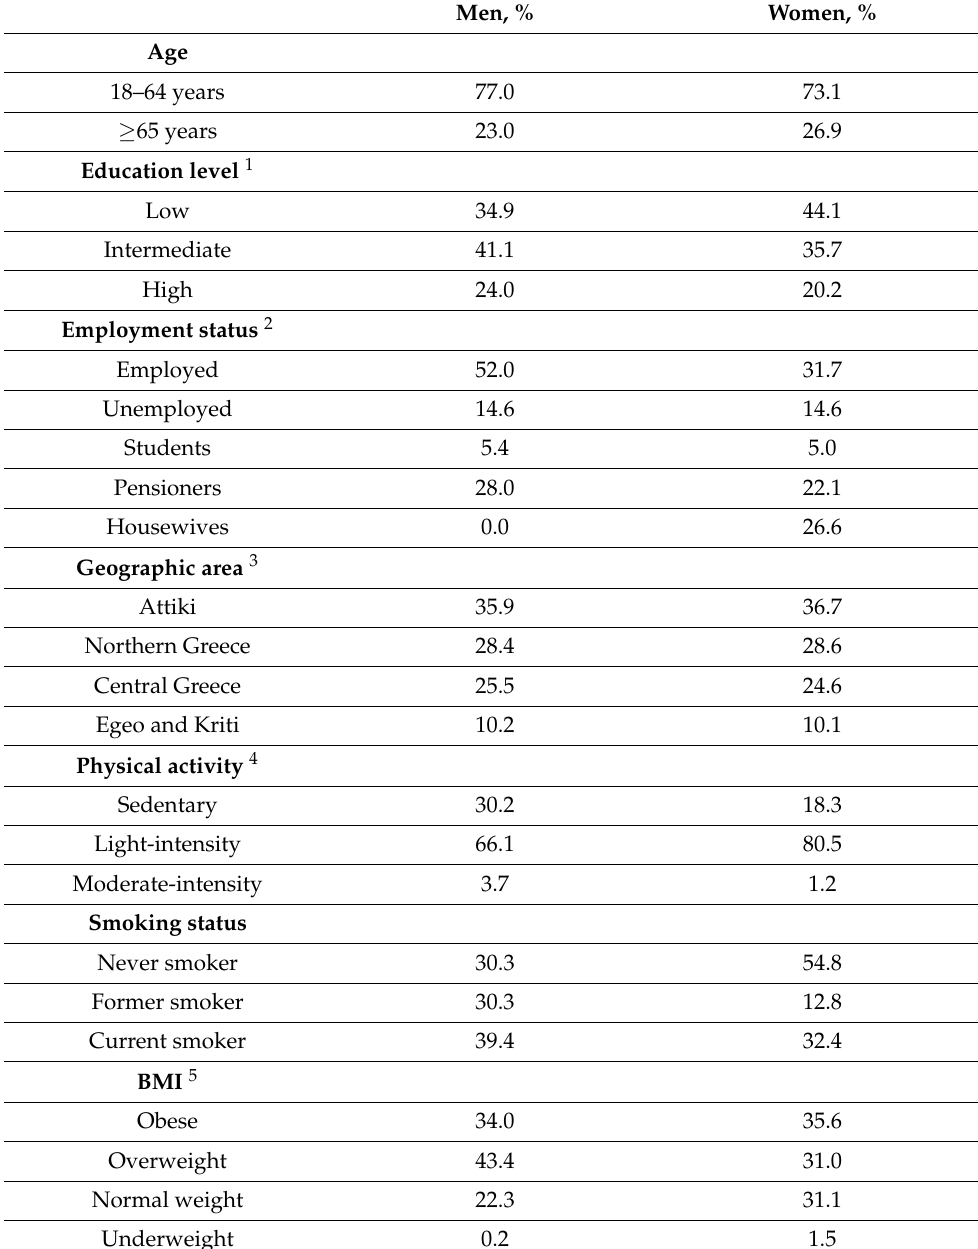
Table 1. Selected sociodemographic and lifestyle characteristics † of participants in the Greek National Health and Nutrition